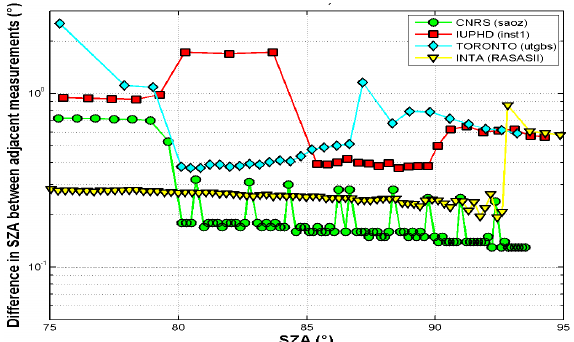
Fig. 14. Difference in solar zenith angle between adjacent measurements by a selection of instruments observing the zenith-sky on 22 June 2009 during evening twilight. The frequent and regular sampling by INTA made it ideal for selection as a reference for a straight-line fit to other instruments’ data. The jump in Toronto’s sampling interval at 87° SZA was caused by the instrument making one of its regular dark current measurements at that time.